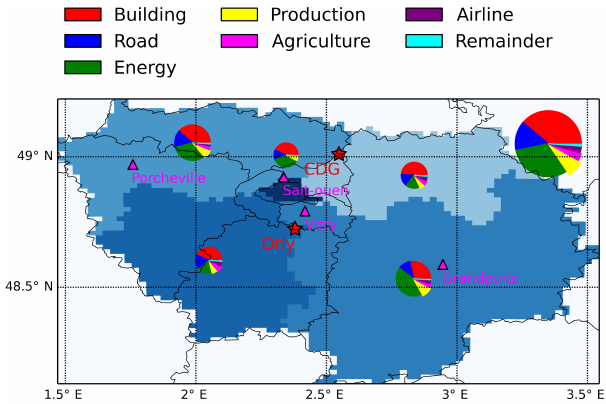
Figure 2. Sectoral budgets of fossil fuel CO 2 emissions from the IER inventory for the five “control” zones (central Paris in dark blue and four other surrounding areas in light blue) partitioning the IDF region and for the month of January in 2011 (see the first seven rows in Table 1 for sector specifications). The circle area is proportional to the emission budge. The upper right largest circle shows the total sectoral budgets for all the five areas of IDF. The red pentagons shows the two airports CDG and Orly, and the purple triangles show several large point emissions such as three EDF power plants and the TOTAL Grandpuits refinery. Note that these five zones in blue mark out the IDF region, but do not strictly follow the administrative borders (black lines) within